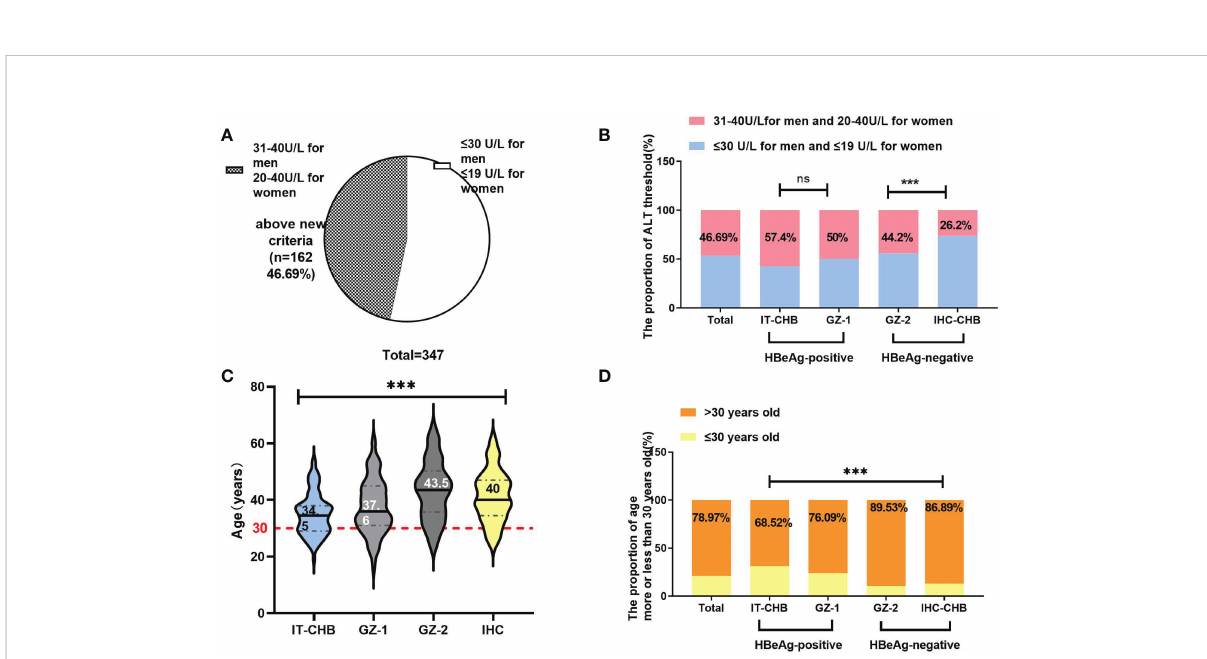
FIGURE 3 The change in antiviral therapy indication by ALT and age. (A) Among patients with ALT<40 U/L, only 53.3% were under the new threshold of ALT (30 U/L for men and 19 U/L for women). (B) Comparison of the proportion of patients exceeding the ALT threshold in different groups. (C) Comparison of the age in different groups (median); (D) Overall, 78.97% (274/347) of patients were over 30 years old. Comparison of the proportion of patients older than 30 years in different groups. ***p<0.001; ns, not signi fi